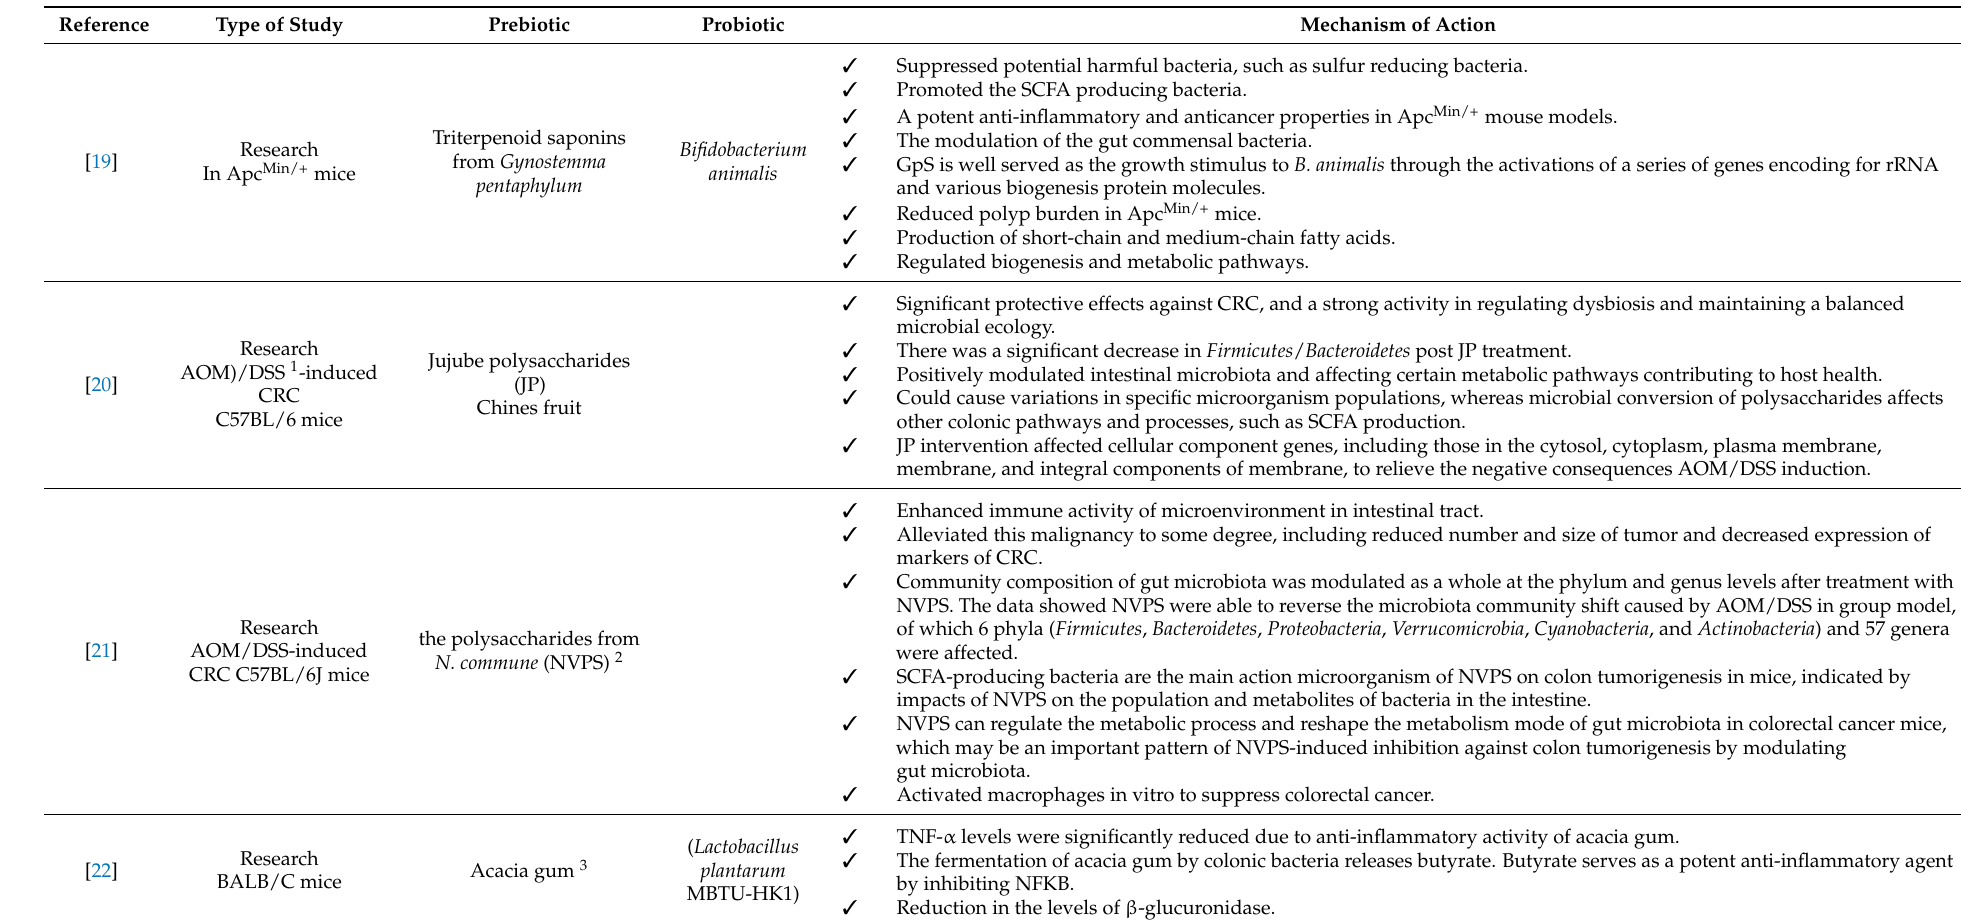
Table 1. Prevention of Colorectal cancer (CRC) Using various prebiotics in